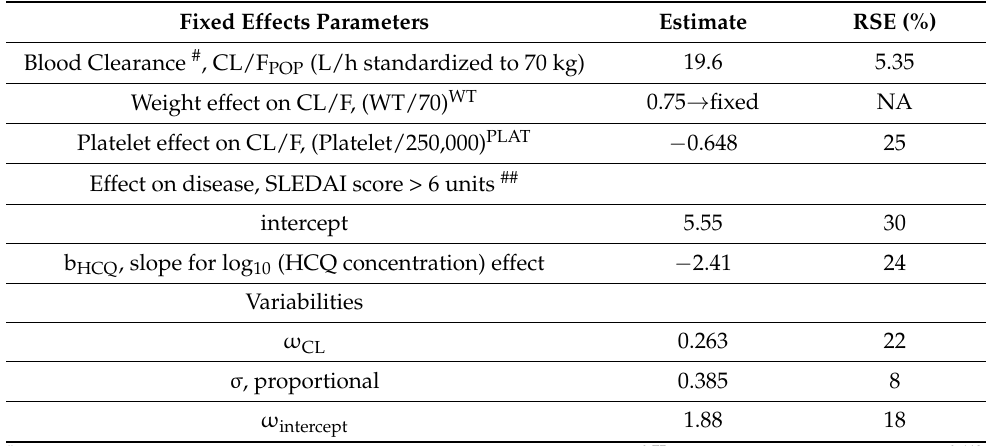
Table 2. Population parameter estimates of HCQ kinetics and effects on disease status, active or non-active disease (SLEDAI score > 6 or not) in 55 children with systemic lupus disease. Fixed Effects